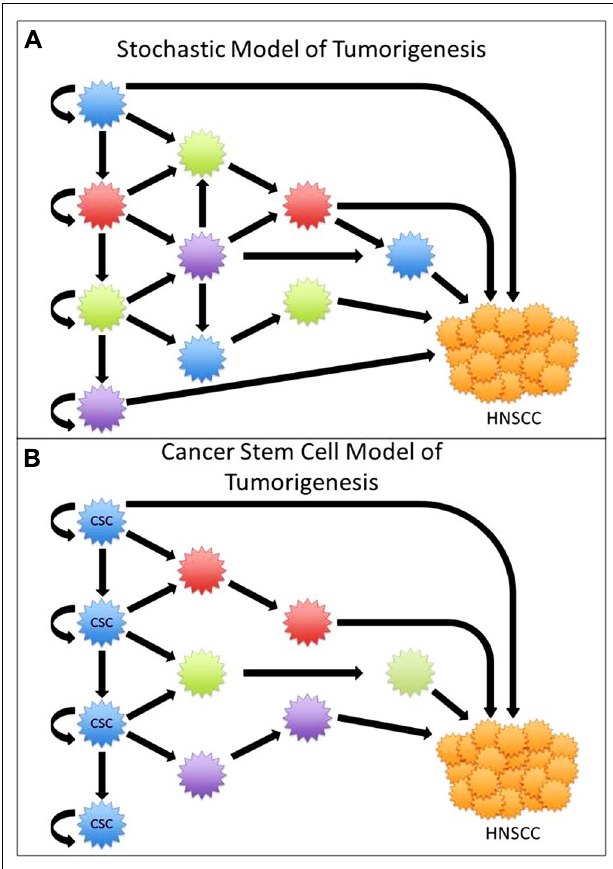
FIGURE 1 | (A) In the stochastic model of tumorigenesis all cells are capable of renewal and tumorigenesis. (B) In the cancer stem cell (CSC) model, only a select group of cells are capable of asymmetric division and